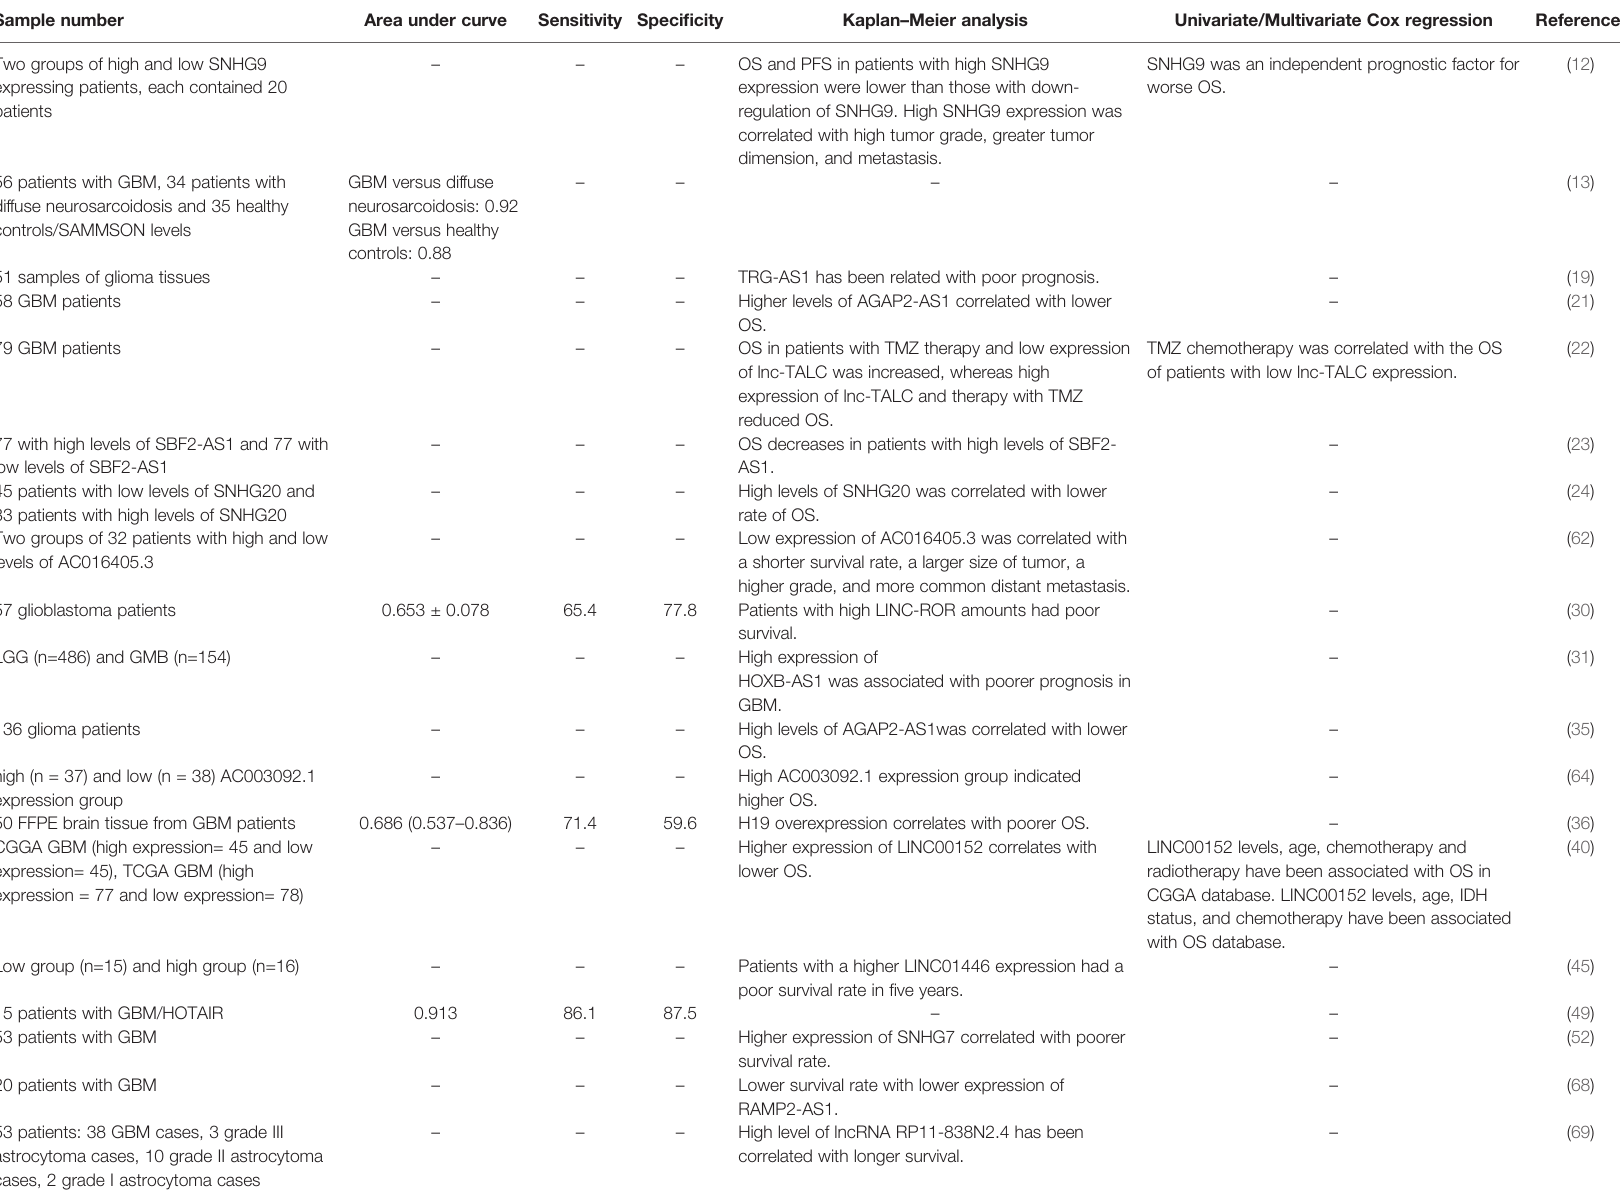
TABLE 3 | Diagnostic/prognostic value of lncRNAs in